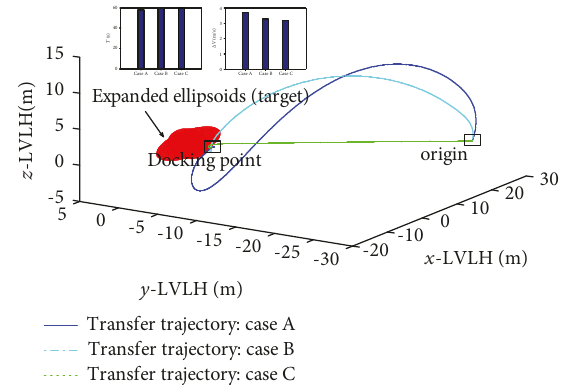
Figure 8: Three-dimensional plot of the transfer trajectories at target ’ s di ff erent initial angular velocities resolved in the target body- fi xed